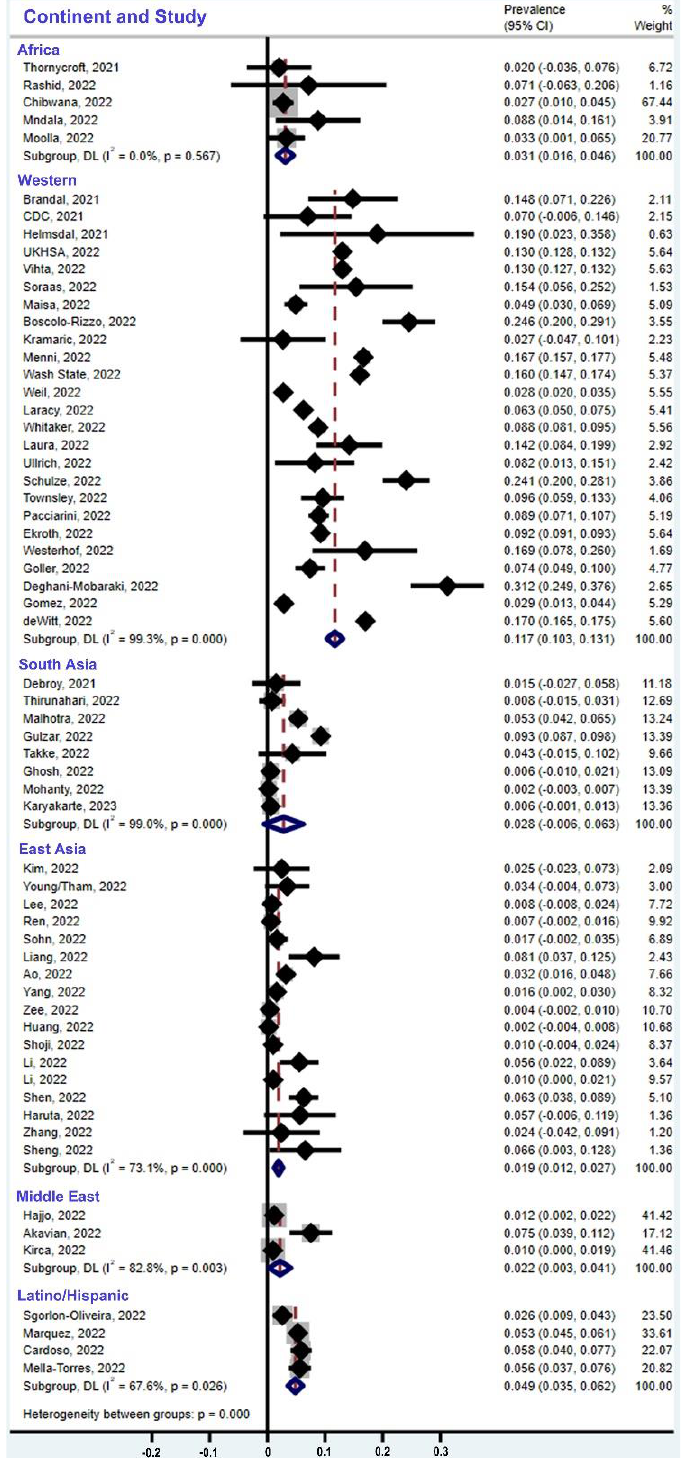
Figure 4. Forest plots of the prevalence of olfactory dysfunction due to omicron by different re- gions/ethnic populations according to the meta-analysis. Prevalence levels are as follows: 3.1% among populations in Africa (CI = 1.6% – 4.6%), 11.7% among people of European ancestry (Western countries, CI = 10.3% – 13.1%), 2.8% in South Asia (CI = 0% – 6.3%), 1.9% in East Asia (CI = 1.2% – 2.7%), 2.2% in the Middle East (CI = 0.3% – 4.1%), and 4.9% among Latinos/Hispanics (CI = 3.5%-6.2%). The size of the light-grey box is proportional to the study weight. The study weights are obtained based on the DerSimonian – Laird method. CI, confidence interval; DL, DerSimonian – Laird method; I 2 , I- squared index.